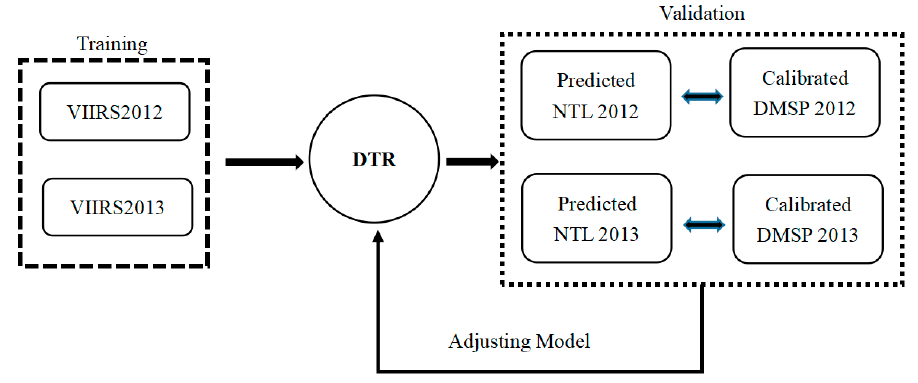
Figure 4. Overlapping data calibration model.